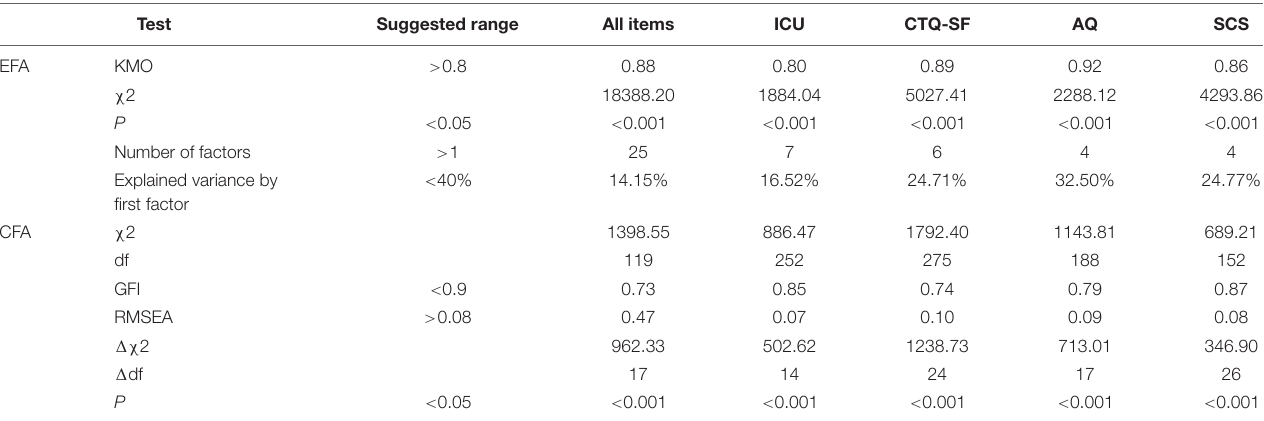
TABLE 3 | Harman’s single-factor test for common method